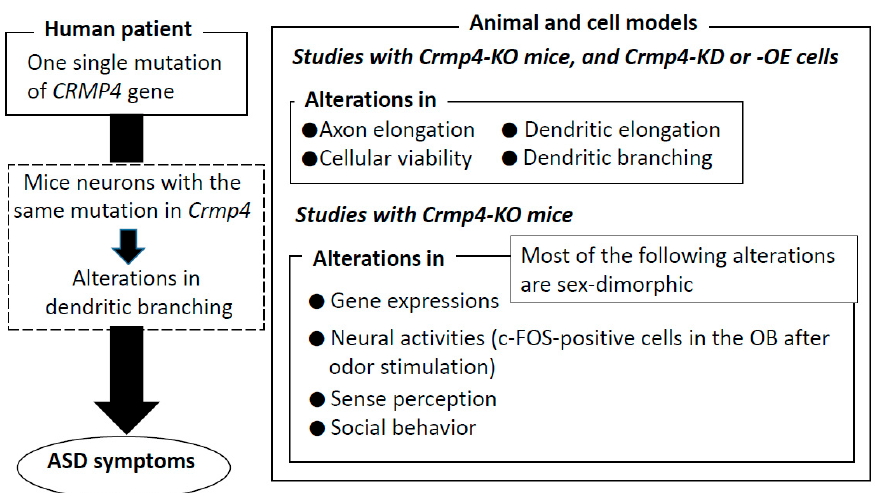
Figure 2. Summary of features associated with deficiency, overexpression, and mutation of Crmp4 .